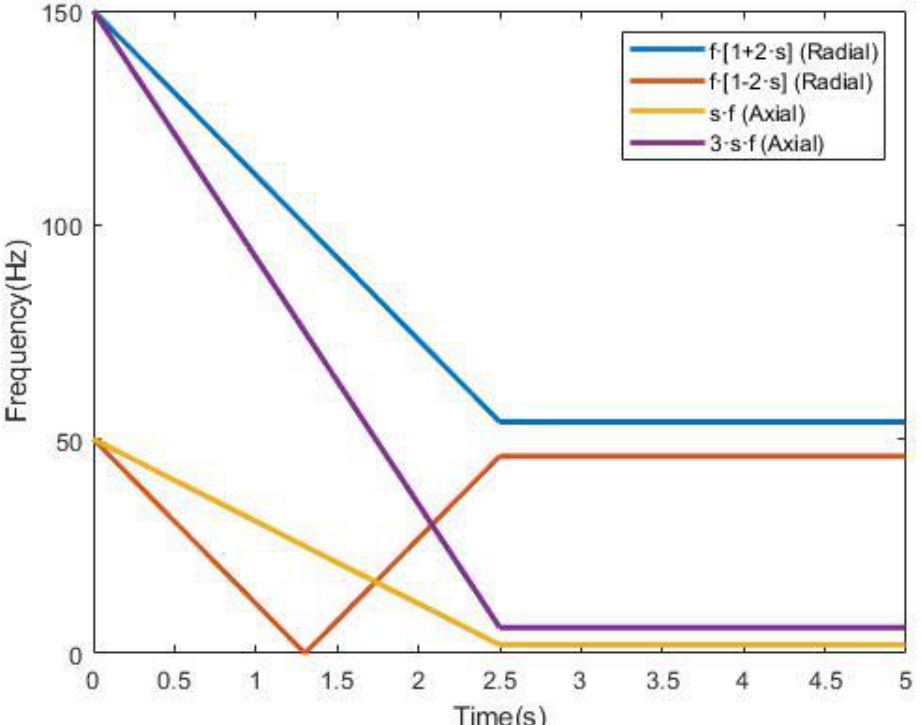
Figure 2. Evolution of radial and axial bar breakage-related components during a direct online start-up transient.